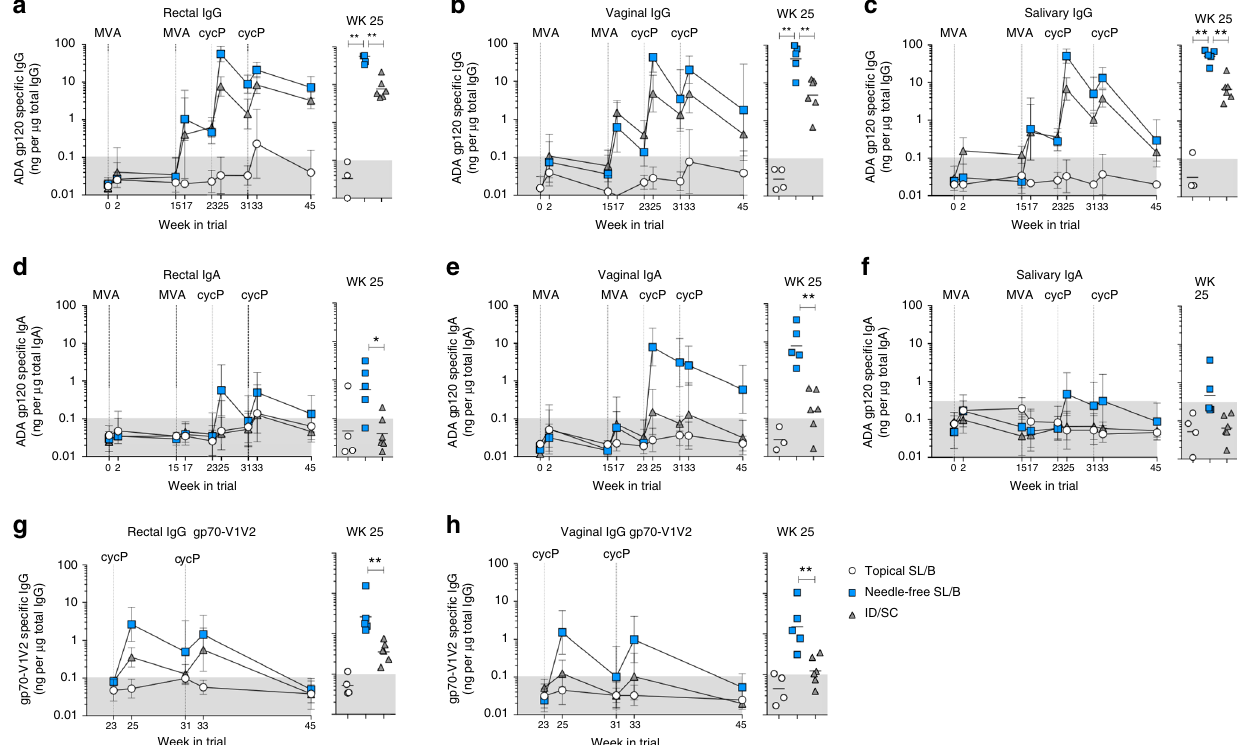
Fig. 3 Needle-free SL/B immunization generates strong mucosal antibody responses. a – c Anti-ADA gp120 IgG antibodies in rectal ( a ), vaginal ( b ), and salivary ( c ) secretions. d – f Anti-ADA gp120 IgA antibodies in rectal ( d ), vaginal ( e ), and salivary ( f ) secretions. Data represented as geomean ± SD speci fi c activity for each group. Speci fi c activity calculated as ng gp120-speci fi c IgG or IgA antibody per μ g total IgG or IgA isolated. Speci fi c activity for individual animals is shown at the peak time point (wk 25); line indicates geomean. The shaded region in each graph indicates the speci fi c activity cut-off value. g – h IgG speci fi c activity against gp70-V1V2 (Clade B/Case A2) in rectal and vaginal secretions. a – h * p < 0.05; ** p < 0.01; Mann – Whitney test. White circle, topical SL/B ( n = 4); blue square, needle-free SL/B ( n = 5); gray triangle, ID/SC ( n =